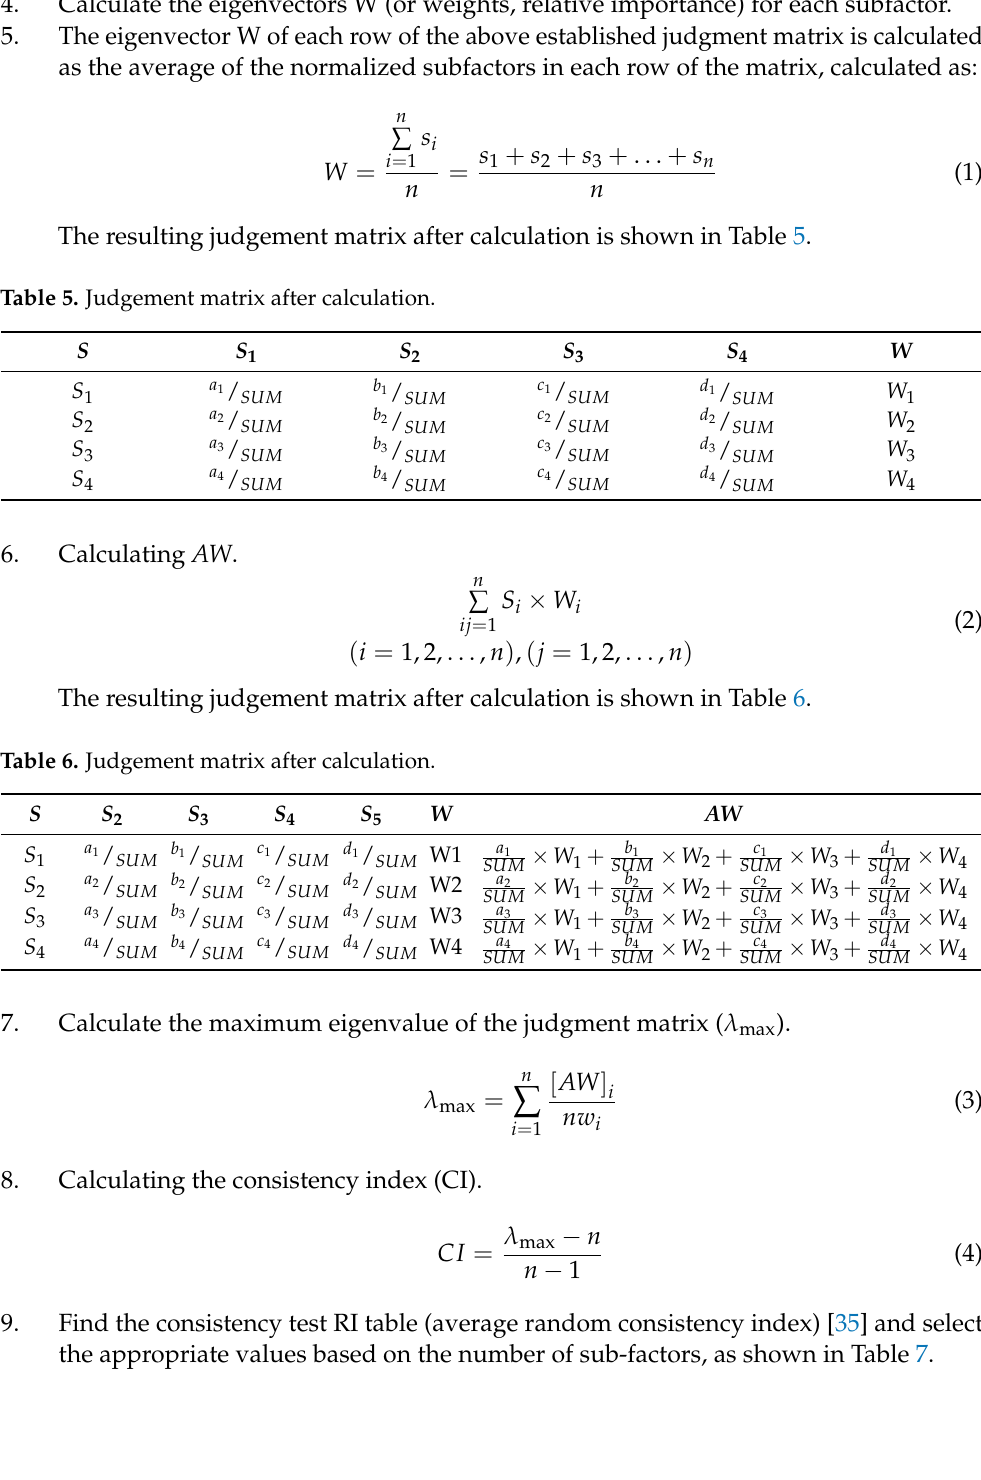
Calculating the consistency index (CI).